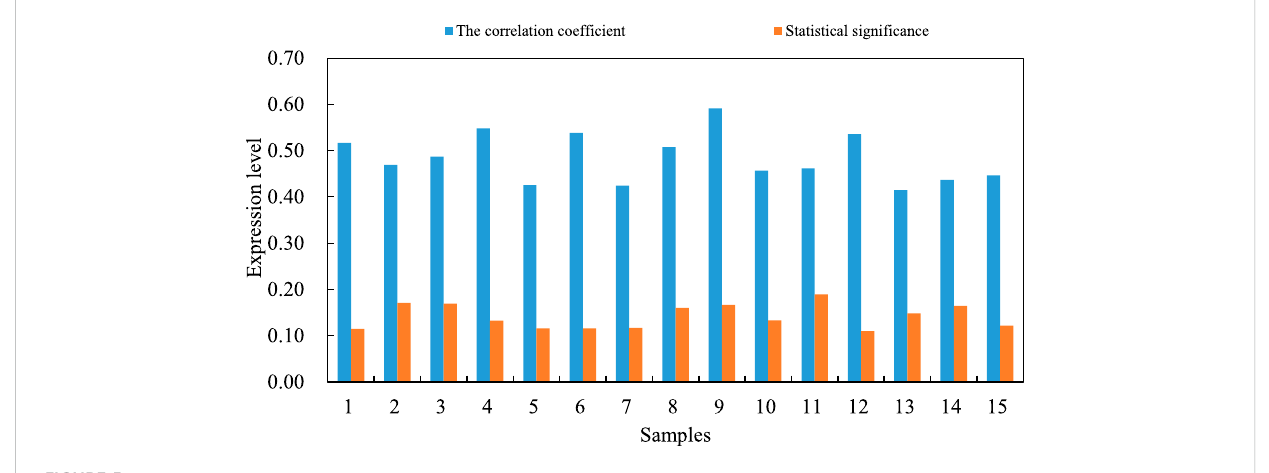
FIGURE 5 Interaction between miR-206 and VEGF/PI3K/AKT signal pathway genes.